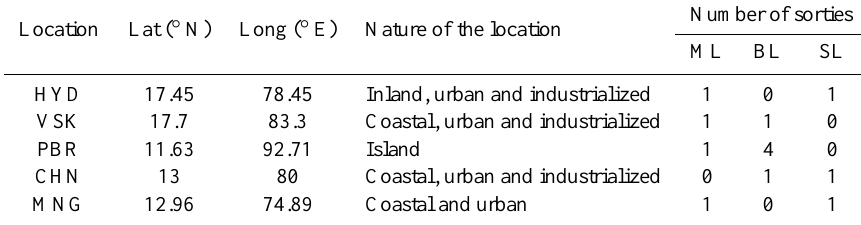
Table 1. Geographical coordinates and characteristics of the base stations.